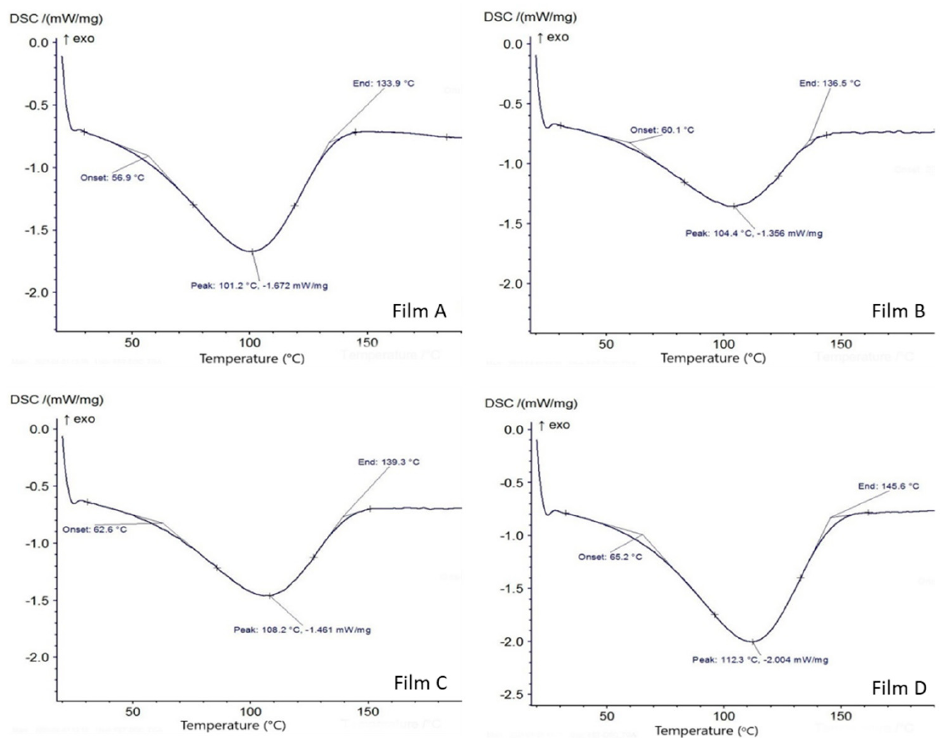
Figure 3. Differential Scanning Calorimetry (DSC) curve for sweet lime peel residue-based film added with 0% EO (Film A ), 1% EO (Film B ), 2% EO (Film C ) and 3% EO (Film D